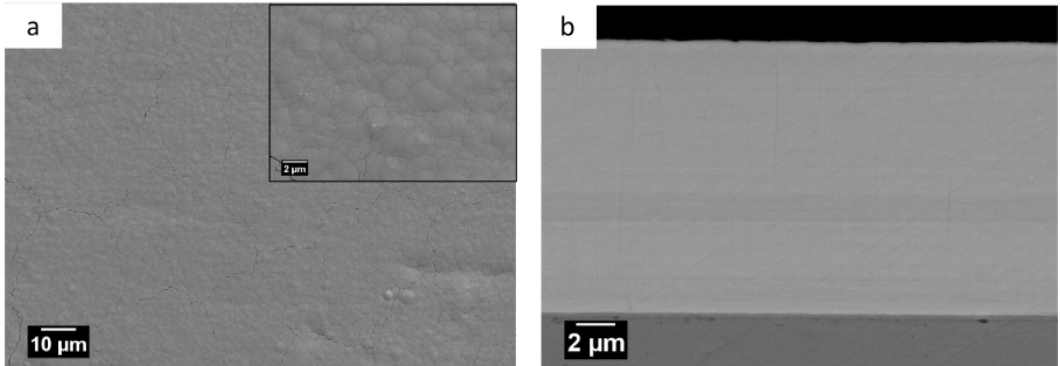
Figure 1. Secondary electron images of the as-deposited Fe-24W samples: ( a ) Surface morphology including an insert of the surface acquired at higher magnification; and ( b ) cross-section.